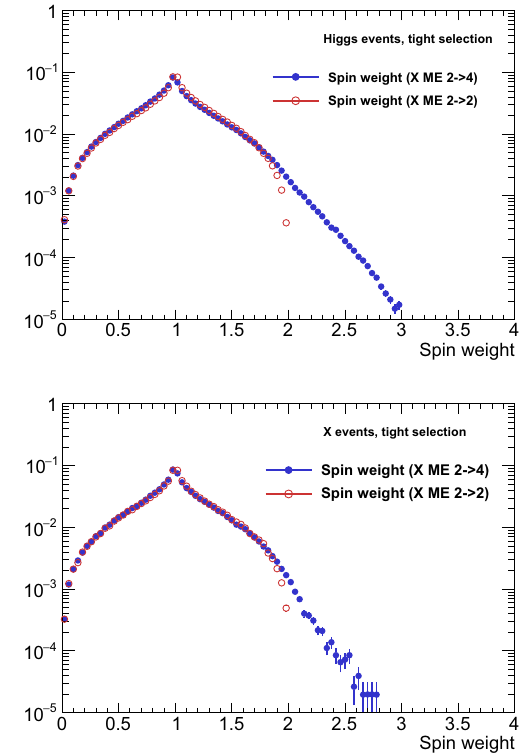
Fig. 5 Spin weight histograms, normalised to unity, obtained from X matrix elements for H sample (top plot) and X sample (bottom plot). In both cases samples are constrained with tight selection cuts. Red open circles are for when the effective Born (2 → 2) matrix elements are used and blue full circle points are for when our new (2 → 4) matrix elements are